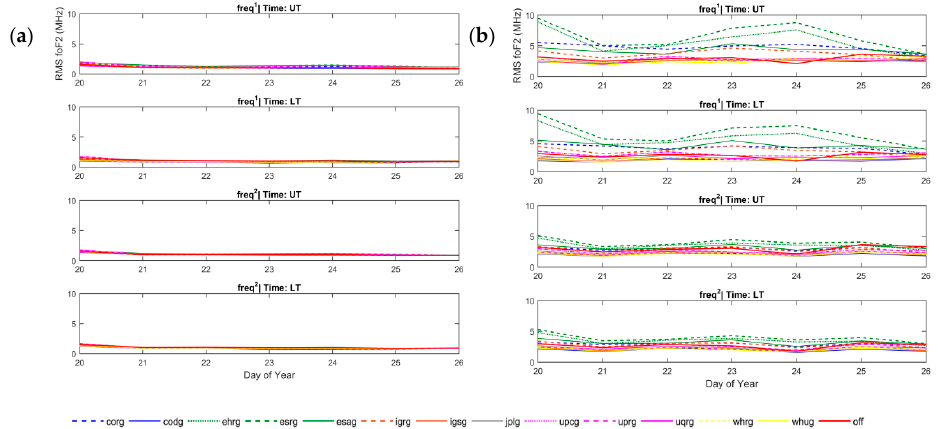
Figure 4. One-week RMS values of the di ff erences between fo F 2 values estimated with the help of the di ff erent GIMs to describe the fo F 2 variation between the values measured at the pair of ionosondes, considering the four approaches described for two pairs of ionosondes: ( a ) FZA0M and SAA0K, the smallest distance; and ( b ) CAJ2M and BVJ03, the longest distance. Table 3. Mean RMS (MHz) of the di ff erences between fo F 2 values measured and estimated with the four approaches presented, considering GIMs products and the simple di ff erence between the values of both ionosondes (o ff ). The error was computed for the week of 020 to 026 of 2015. Config